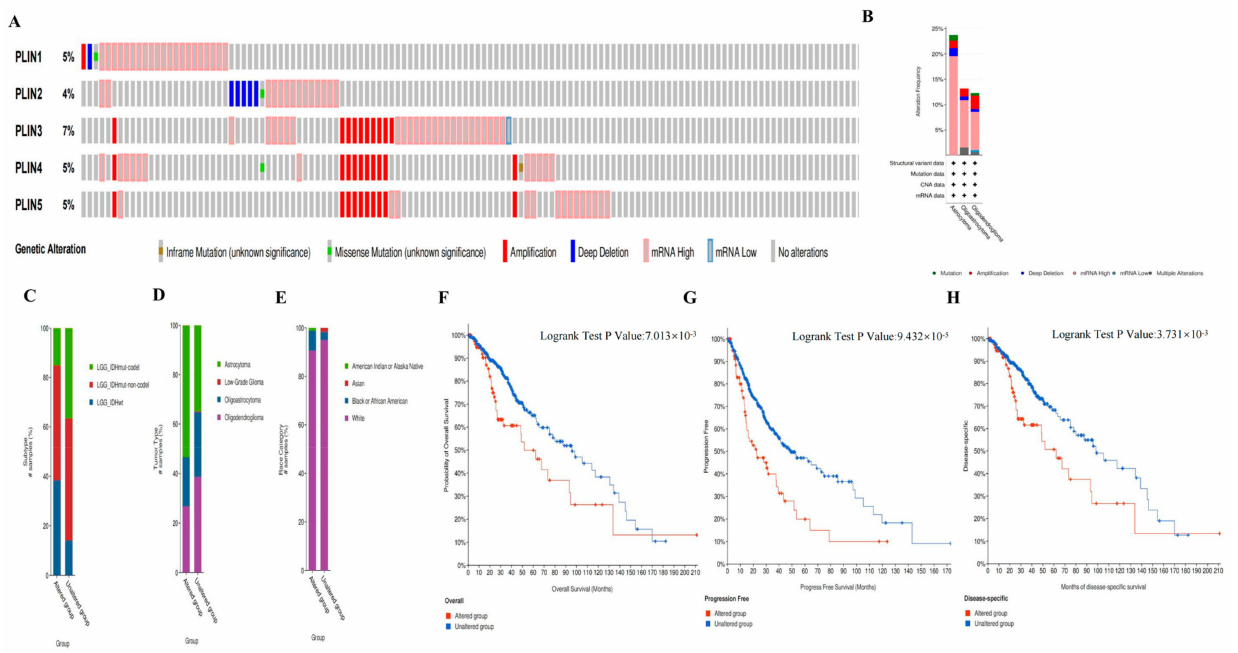
Figure 6. Gene alterations in the PLINs family in LGG. ( A – B ) Frequency and type of genetic alterations of PLINs in LGG. ( C ) Patients with IDH wild type in LGG were more likely to have family alterations in PLINs . ( D ) Astrocytoma was more likely to have PLINs family gene mutations. ( E ) Blacks or African American LGG patients were more likely to have family alterations in PLINs. ( F – H ) Prognostic analysis of genetically altered and non-altered groups of PLINs families in LGG. (+: contains the included